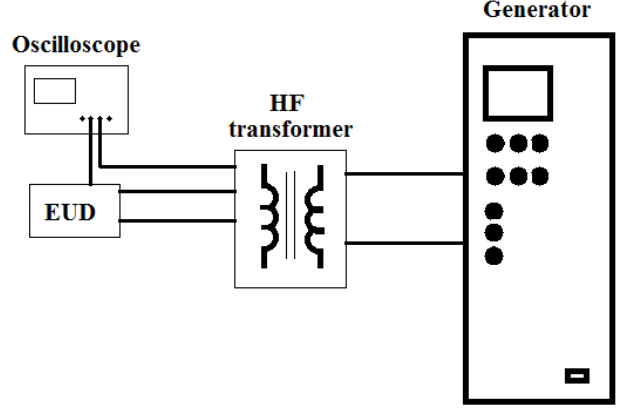
Figure 5. Simplified measurement scheme of drone components.